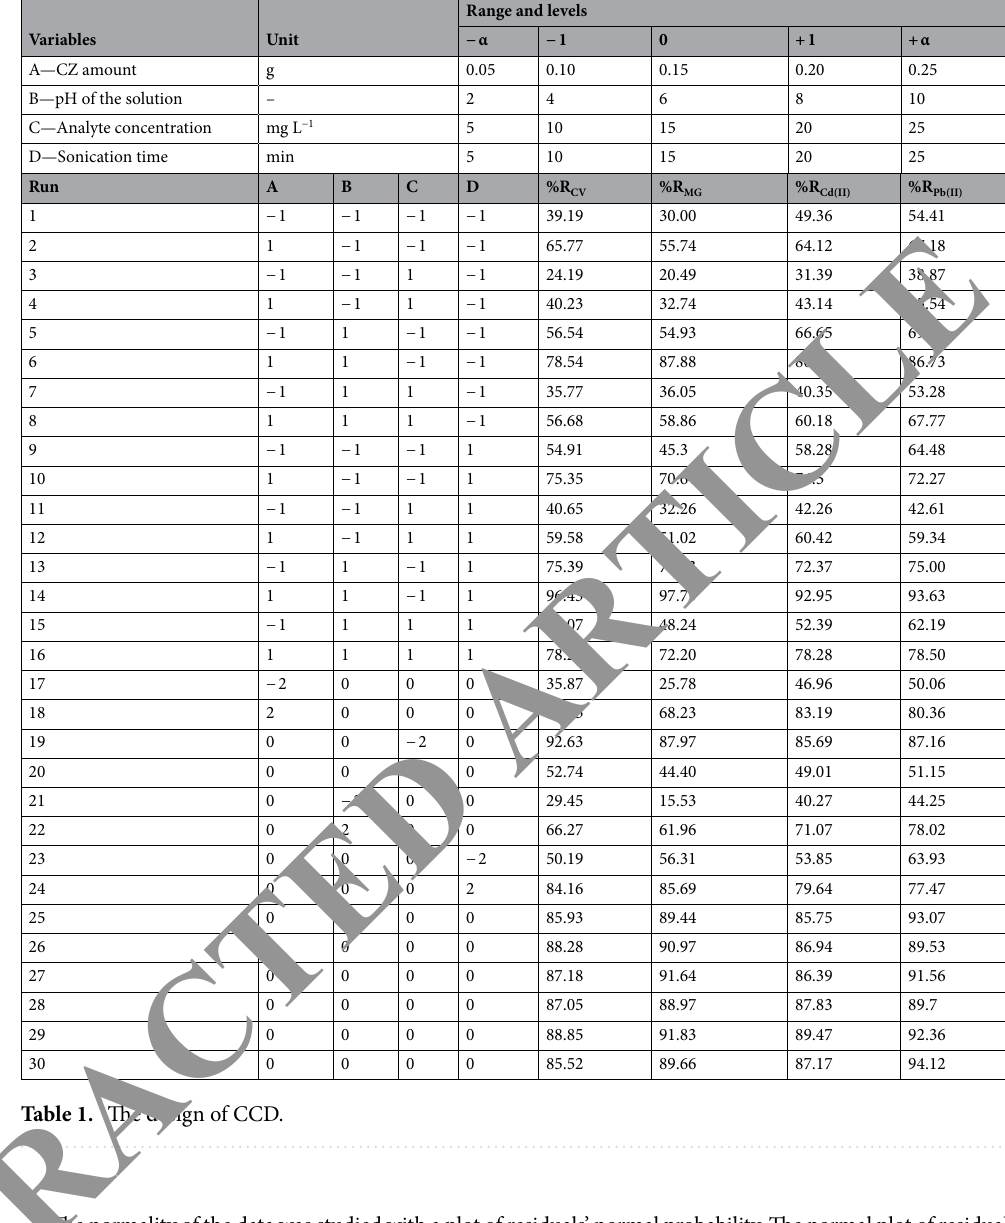
Table 1. The design of